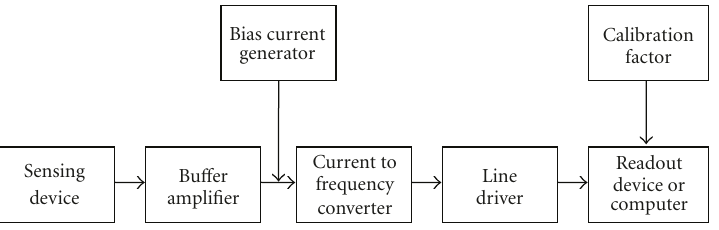
Figure 1: Block diagram showing overview of concept and signal processing chain.